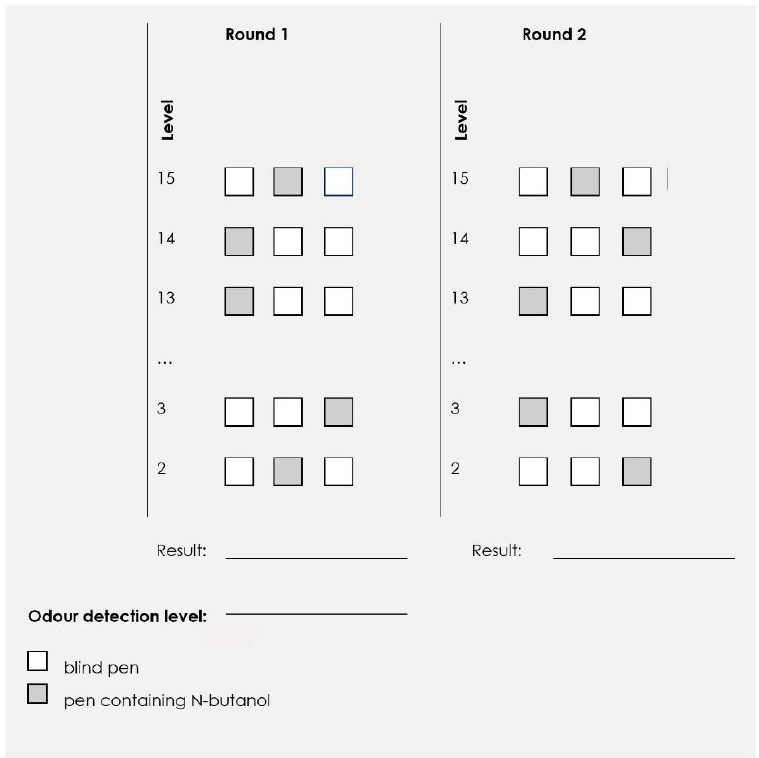
Figure 3. Results sheet for the assessment of the odor reduction efficiency of FFRs.